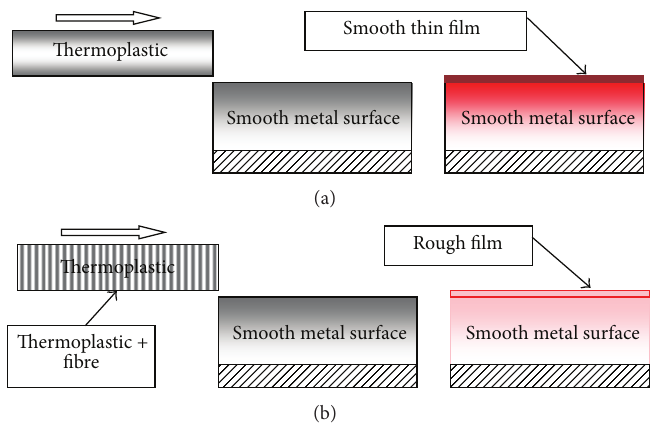
Figure 2: The possible film transfer when thermoplastics or fibre thermoplastic composites sliding condition on metal surface.